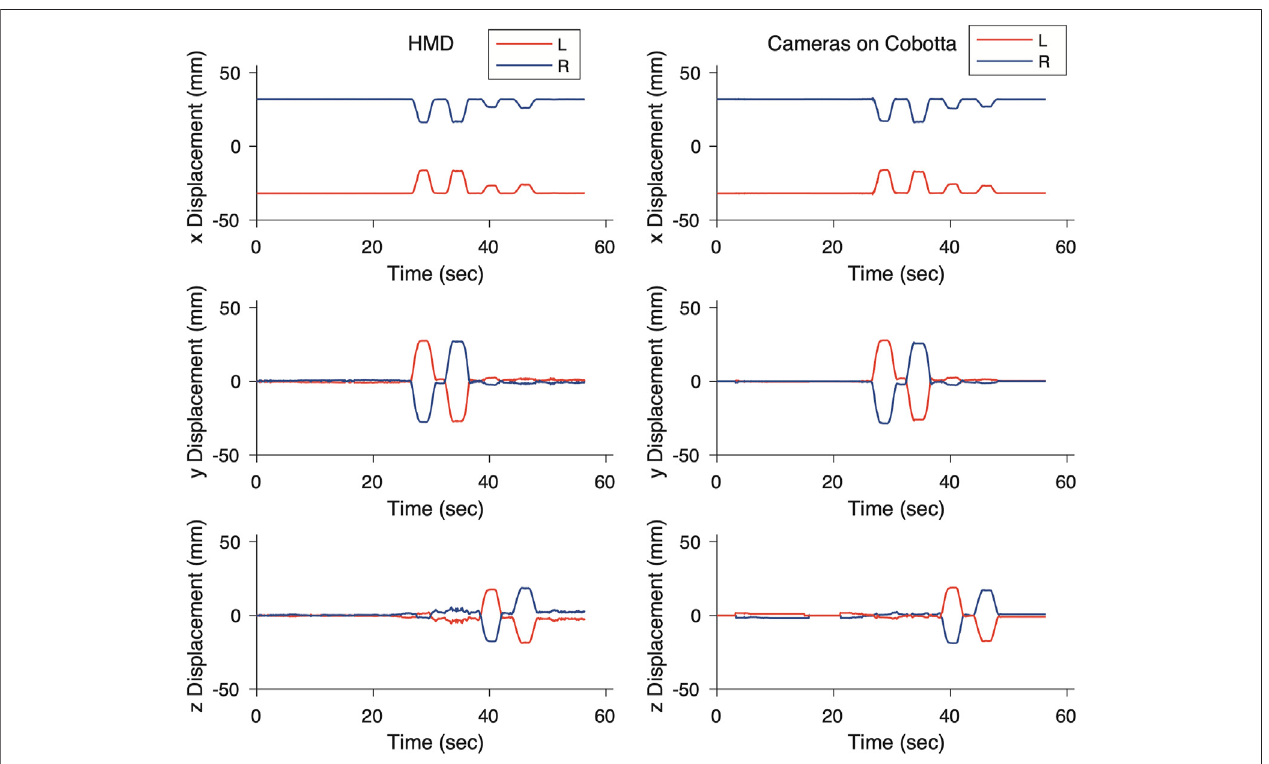
FIGURE 8 | Position pro fi les of eyes and camera lens during head motion.